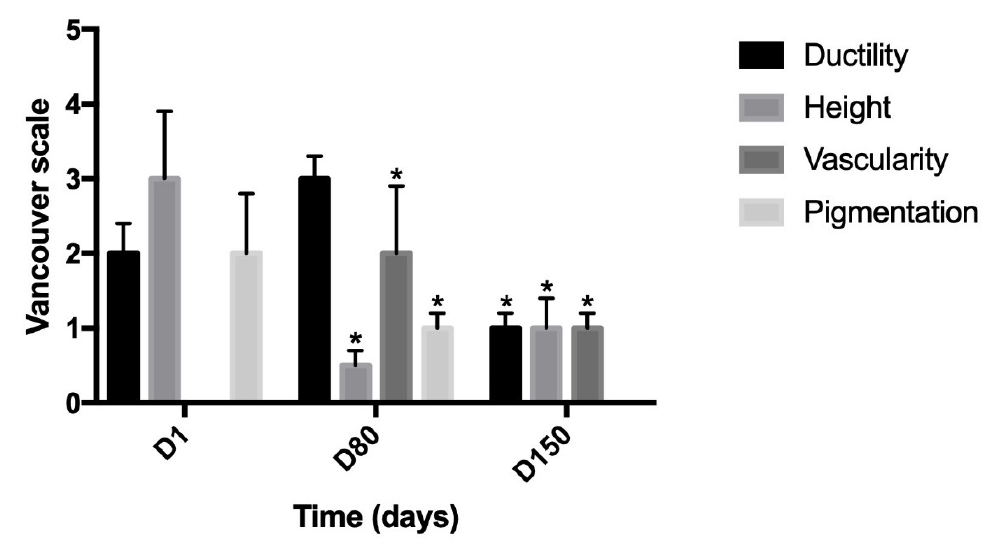
Figure 4. Modified Vancouver scale for the evaluation of ductility, height, vascularity and pigmen- tation. Modified Vancouver Scale used to estimate the improvement of the skin appearance in com- parison to D0 (before treatment), after 1 day, 80 and 150 days. The parameters considered are duc- tility, height, vascularity and pigmentation. * p > 0.05.